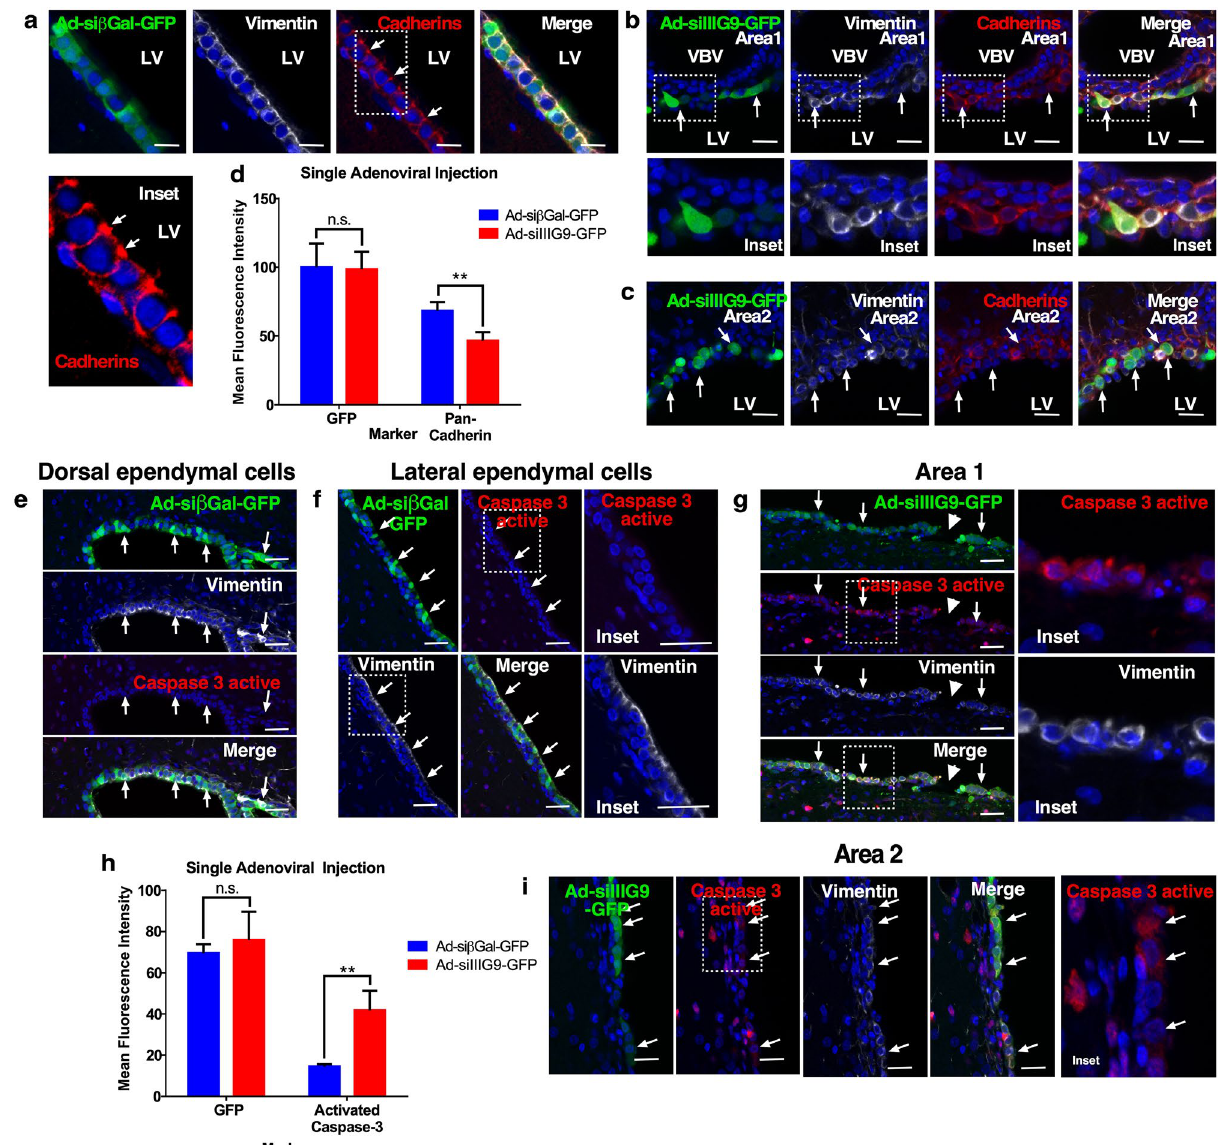
Figure 4. Loss of IIIG9 function induces cadherin redistribution and caspase-3 activation in ependymal cells. ( a ) Ad-siβGal-GFP expression and immunohistochemistry analysis. Ependymal cell layer expressing GFP, vimentin and cadherins (arrows). Cadherins were mainly detected in cell-to-cell contacts (arrows and insets). ( b ) Ad-siIIIG9-GFP expression and immunohistochemistry analysis. Altered ependymal cell layer expressing GFP, vimentin and cadherins (arrows). Lateral ventricle dorsal area. ( c ) Ad-siIIIG9-GFP expression and immunohistochemistry analysis. Altered ependymal cell layer expressing GFP, vimentin and cadherins (arrows). Lateral ventricle lateral area. Reduced cadherin expression (red channel). ( d ) Mean fluorescence intensity plot of decreased cadherin immunoreactivity in ependymal cells from Ad-siIIIG9-GFP animals compared to the controls. Data represent the mean ± SEM from at least four independent biological replicates. ( e – f ) Ad-siβGal-GFP expression and immunohistochemistry analysis. GFP, vimentin and caspase-3 active detection in dorsal ( e ) and lateral ( f ) ependymal cells (arrows and insets). ( g – i ) Ad-siIIIG9-GFP expression and immunohistochemistry analysis. GFP, vimentin and active caspase-3 detection in the dorsal ( g ) and lateral ( i ) ependymal walls (arrows and insets). Rounded cells with active caspase-3 (arrows and insets) were present near ependymal cell denudation areas (arrowhead and insets). ( h ) Mean fluorescence intensity plot of active caspase-3 increased immunoreactivity in ependymal cells from Ad-siIIIG9-GFP animals compared to the controls. All images are representative of different biologically independent samples. LV lateral ventricles, VBV blood vessel. ( a – c , e – g , i ) n = 4. ( d , h ) data are shown t-student (two-tailed) as mean ± SEM; all data are representative of four separate experiments. ** P < 0.01, ns not significant. Scale bars = ( a – c ) 20 μm; ( e – f , g , i ) 40